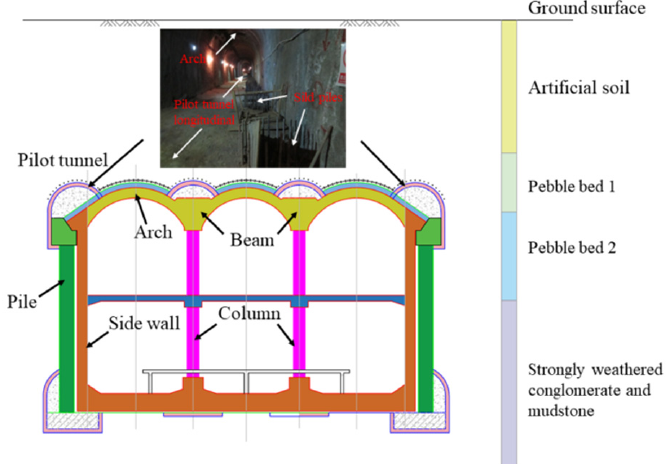
Figure 1. Structural profile of Daguanying